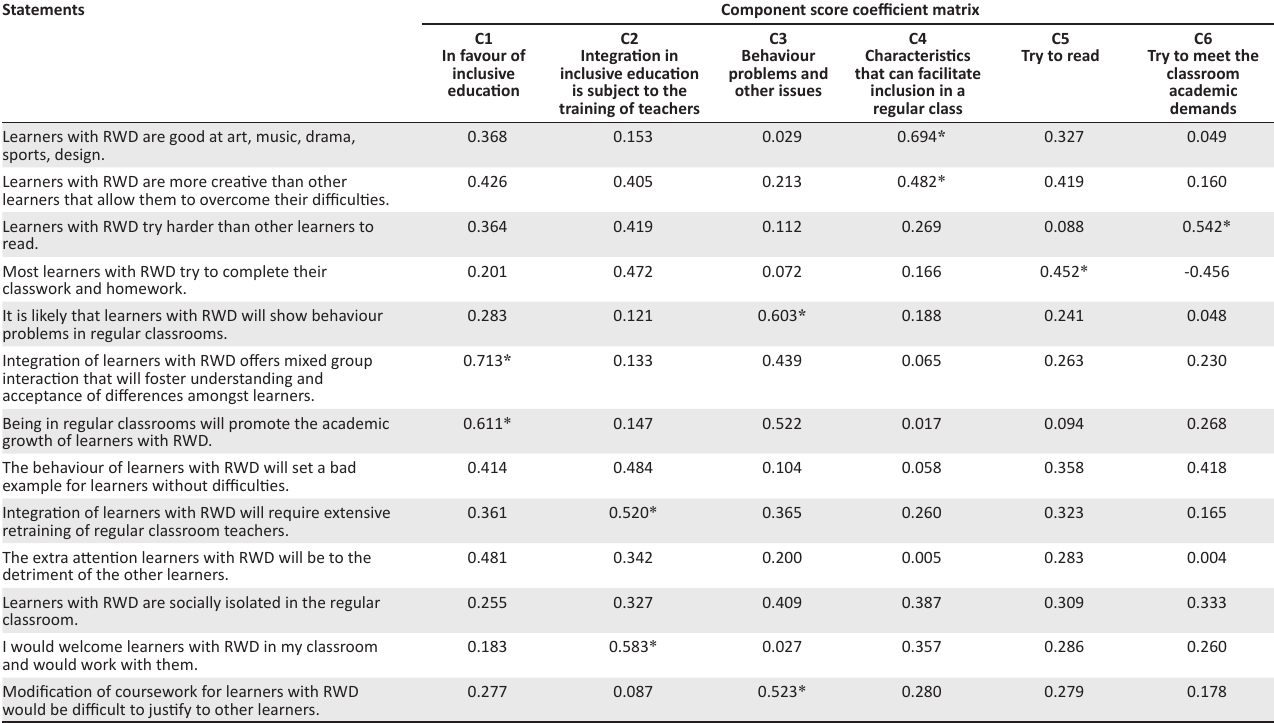
TABLE 7: Component score coefficient matrix for participant’s perspectives about characteristics and their views on learners with reading and writing difficulties in an inclusive